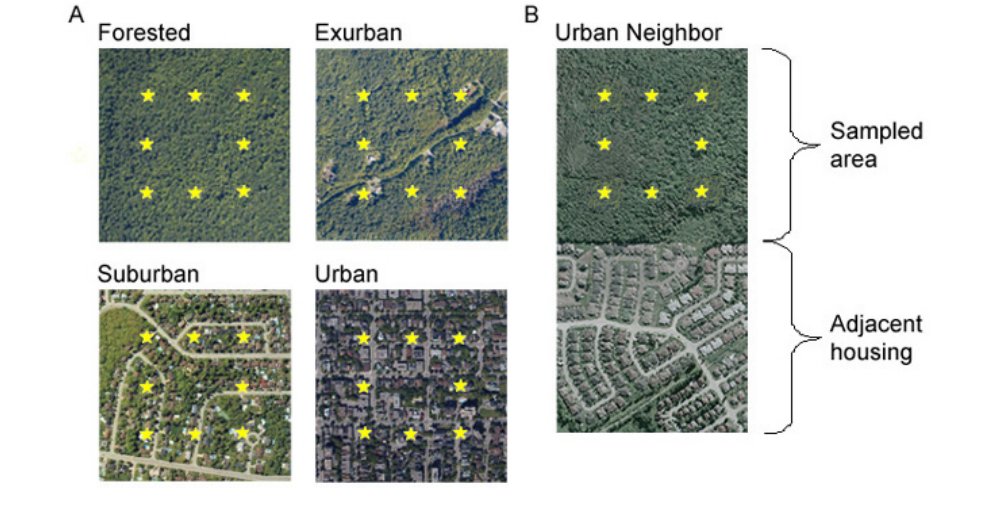
Fig. 2 . Typical sites in which carabid beetles were surveyed. All beetle survey sites were 500 × 500 m. The planned locations of pitfall trapping stations are shown as yellow stars (see text for how planned and actual station locations differed). (A) Example sites representing a range of housing densities; we surveyed four replicate sites of each type. (B) Example Urban Neighbor site: the 500 × 500 m forested beetle survey site was adjacent to at least 500 × 500 m of Urban-density development. We surveyed three replicate Neighbor sites adjacent to each of the Suburban and Urban housing density